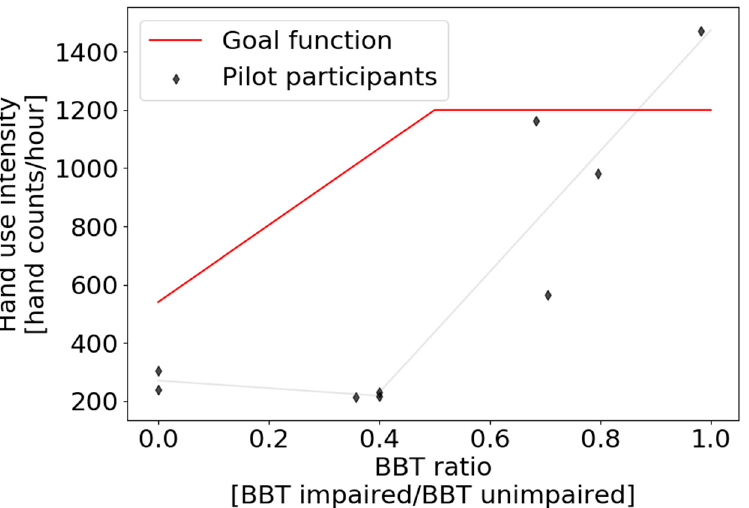
Figure 2. Hand count intensity goal function (red line) based on the BBT ratio between the impaired and unimpaired hands. The function was based on data acquired from pilot participants who wore the Manumeter during one day (diamonds). After the hand count intensity goal was defined, the daily goal was obtained by multiplying the intensity goal by the 10 h of expected daily wear time.